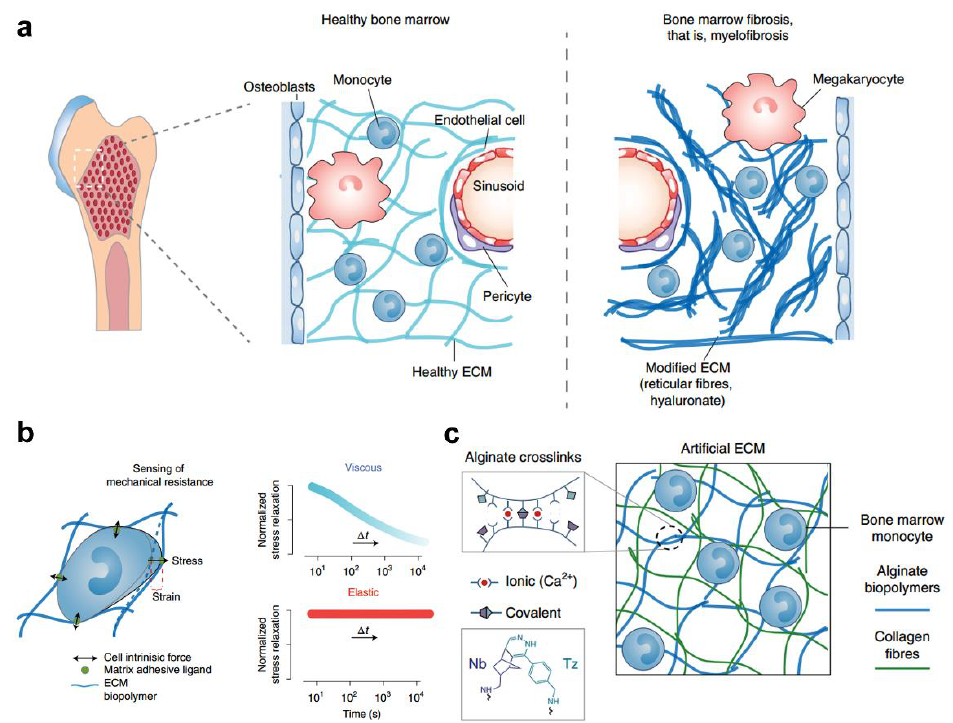
Figure 9. Alginate and collagen interpenetrating network hydrogel for regulating monocyte differentiation in fibrotic niches. ( a ) In myeloproliferative neoplasms, abnormal haematopoiesis is associated with inflammation and substantial ECM remodeling. ( b ) Bone marrow cells sense the stiffness and viscoelasticity of the matrix. ( c ) Alginate was chemically modified with norbornene (Nb) and tetrazine (Tz), which covalently reinforce existing ionic (Ca 2+ ) hydrogel crosslinks to modulate viscous performance independently of stiffness. (Reprinted/adapted with permission from Ref. [19], 2022, Vining et al.).